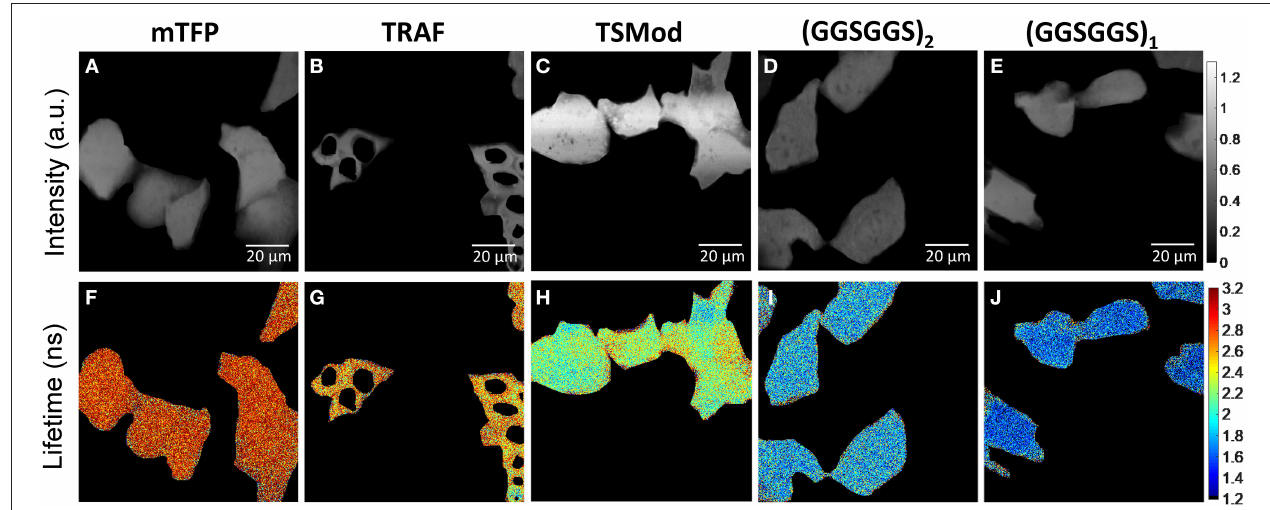
FIGURE 1 | Representative images of iBMK cells expressing mTFP1 and the FRET constructs mTFP1-TRAF-mVenus, mTFP1-TSMod-mVenus, mTFP1-(GGSGGS) 2 -mVenus, and mTFP1-(GGSGGS) 1 -mVenus acquired at 450nm excitation with emission centered at 479nm. (A–E) Fluorescence intensity in arbitrary units (a.u.). (F–J) Corresponding fluorescence lifetime images (color scale in ns). All images are captured with 1,024 point. The cells were manually